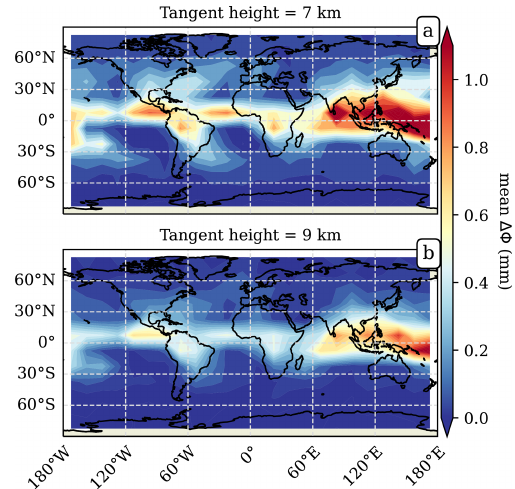
Figure 4. Global climatology maps for the mean PAZ (cid:49)(cid:56) obser- vations corresponding to a tangent height of 7km (a) and 9km (b) . The grid size, where the means are computed, is 15 × 15 ◦